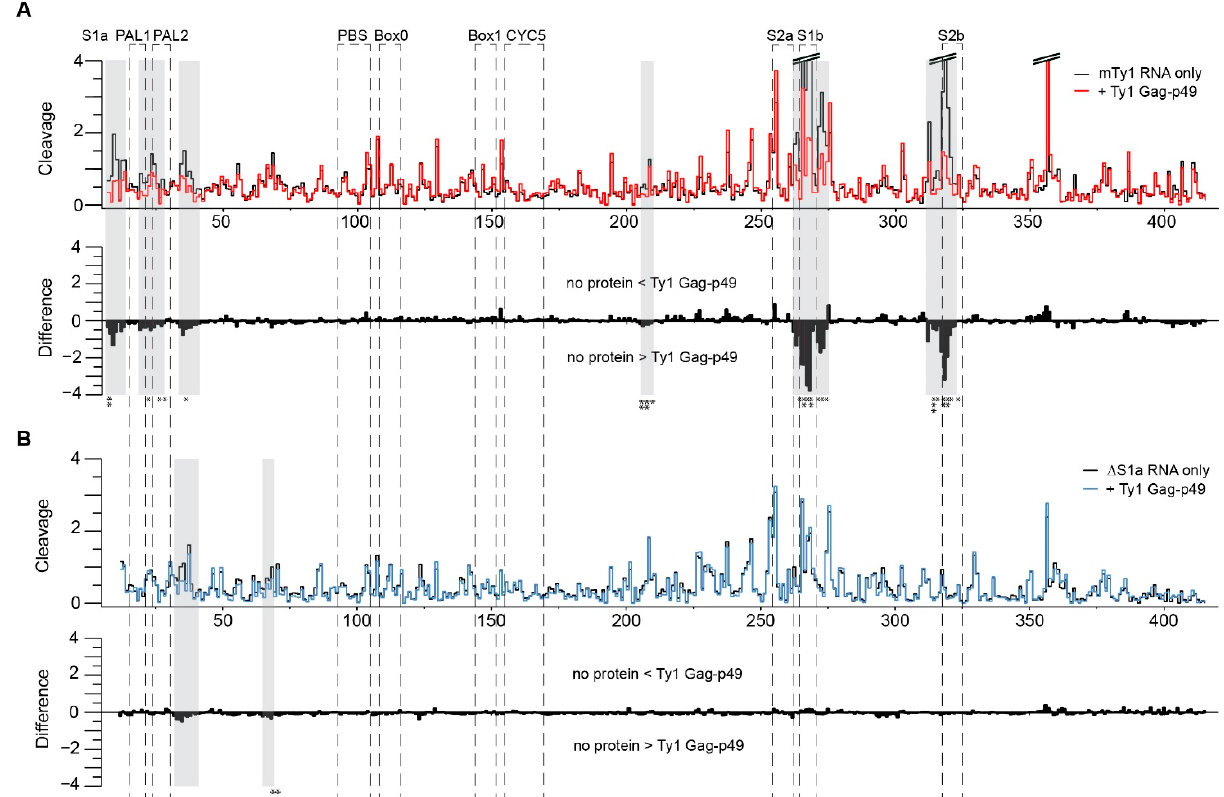
Figure 6. Ty1 Gag ‐ p49 binding sites on mTy1 ( A ) and Δ S1a RNA ( B ). Hydroxyl radical (HR) cleavage profiles and difference plots of protein free RNA (black) in comparison with RNA probed in the presence of Gag ‐ p49 (red for mTy1 RNA and blue for Δ S1a RNA). On the difference plots, sites of decreased HR cleavage upon Gag ‐ p49 binding are indicated by negative peaks. Regions showing significant decrease HR reactivity over several nucleotides are indicated by gray stripes (absolute cleavage decrease of >0.2 and/or a p ‐ value < 0.05). Asterisks below the plot correspond to statistical significance (Student ′ s t ‐ test). Regions important for Ty1 retrotransposition are boxed.